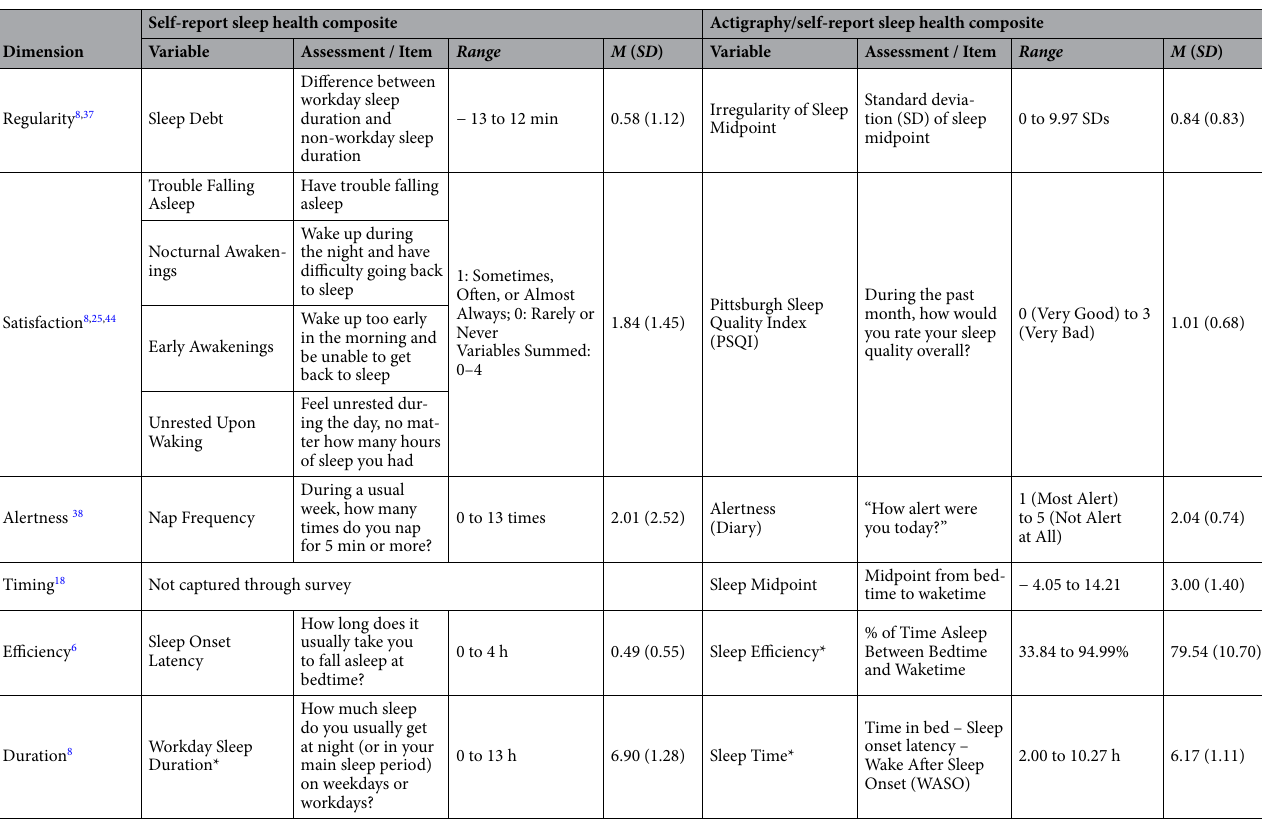
Table 1. Sleep health dimensions to construct two sleep health composites. *Indicates that continuous variables were reverse coded, so that higher values represent poorer sleep.